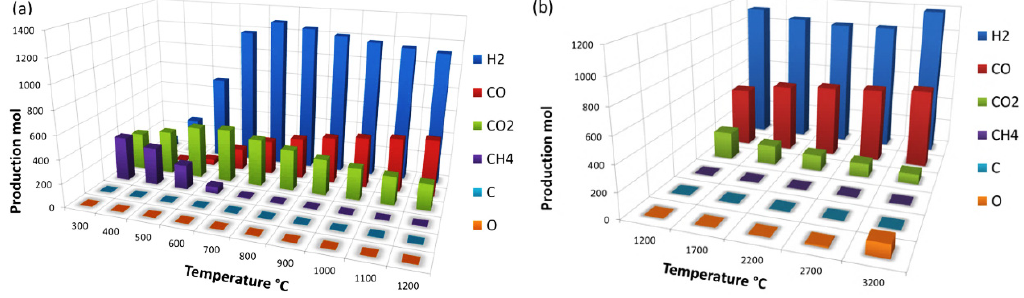
Figure 7. Production of substances from ( a ) 300–1200 °C and ( b ) 1200–3200 °C at 0.1 MPa and ratio w / g